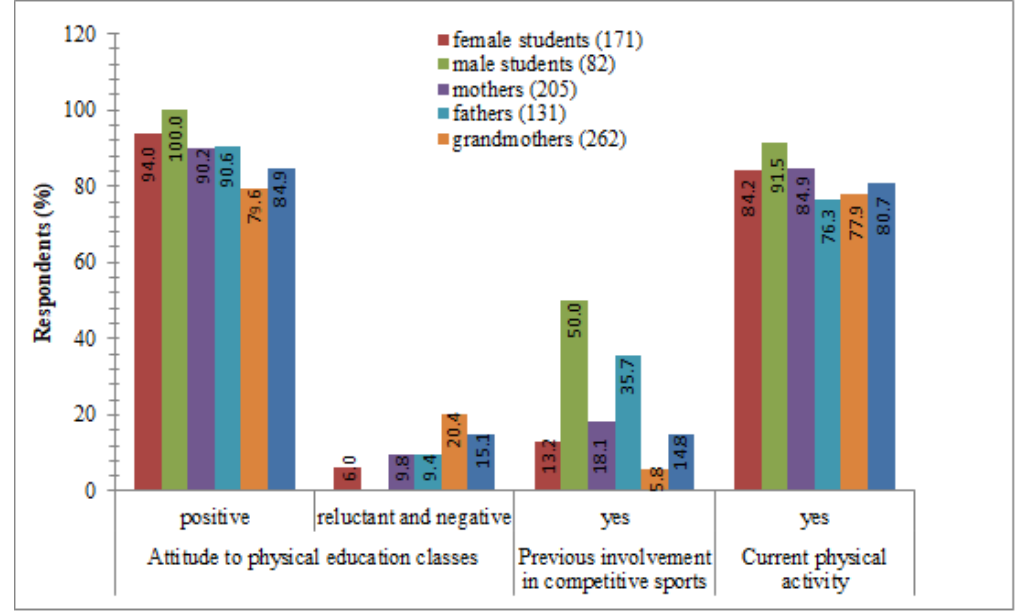
Figure 1. Physical activity characteristics of university students, their parents, and their grandparents (independence χ2 test and Cramér’s V).